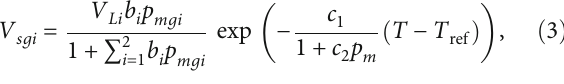
/N , CH ) and water during CBM, CO 2 2 4